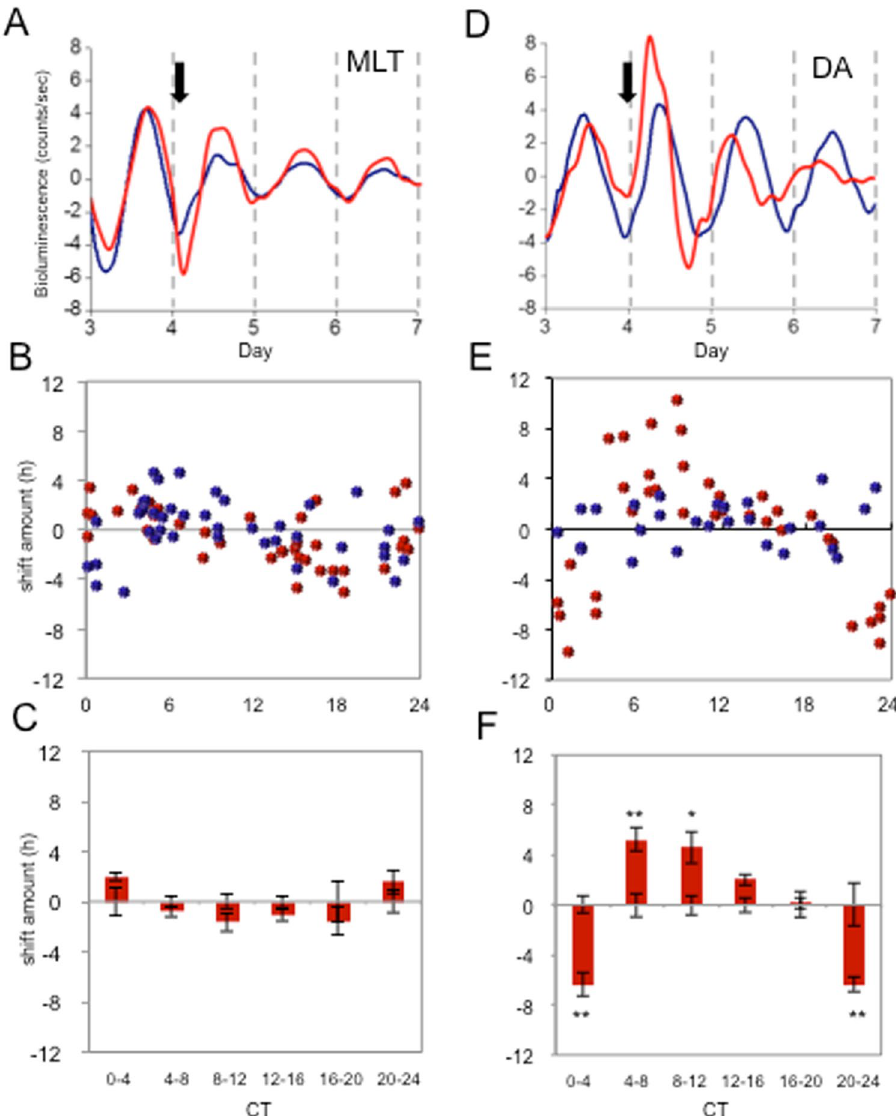
Figure 1. Dopamine phase-shifts PER2::LUC bioluminescence rhythms in mouse RPE-choroid. DA or MLT were added to the culturing media after the third peak of the RPE-choroid PER2::LUC bioluminescence rhythm. The representative data shows application of MLT at CT 14 did not phase-shift the RPE-choroid bioluminescence PER2::LUC rhythm ( A ). On the other hand, DA application at CT 8 phase-shifted the RPE- choroid bioluminescence rhythm ( D ). The blue traces indicate controls (vehicle treated) while red traces indicate MLT ( A ) or DA ( D ) treated RPE-choroid cultures. The black arrows indicate time of the drug or vehicle (Veh) treatments ( A and D ). The amount of phase-shift for each individual RPE-choroid rhythm was plotted to create a PRC ( B and E ). Blue circles indicate cultures treated with Veh and red circles indicate culture treated with either MLT ( B ) or DA ( E ). Data were divided into 6 bins at 4-hour intervals for statistical analysis. Data were then used to calculate the phase change of MLT or DA versus their vehicle controls. Bars show the mean amount of phase change from controls and error bars show ± SEM for experimental groups. Error bars from x axis show ± SEM for control groups. MLT did not phase-shift the RPE-choroid PER2::LUC bioluminescence rhythm (n = 4–14 for each bin, Two way ANOVA, p > 0.1, ( C ) whereas DA significantly phase-shifted PER2::LUC rhythm (Two way ANOVA following Tukey tests, * p < 0.05, ** p < 0.01, n = 6–8 for each bin, ( F